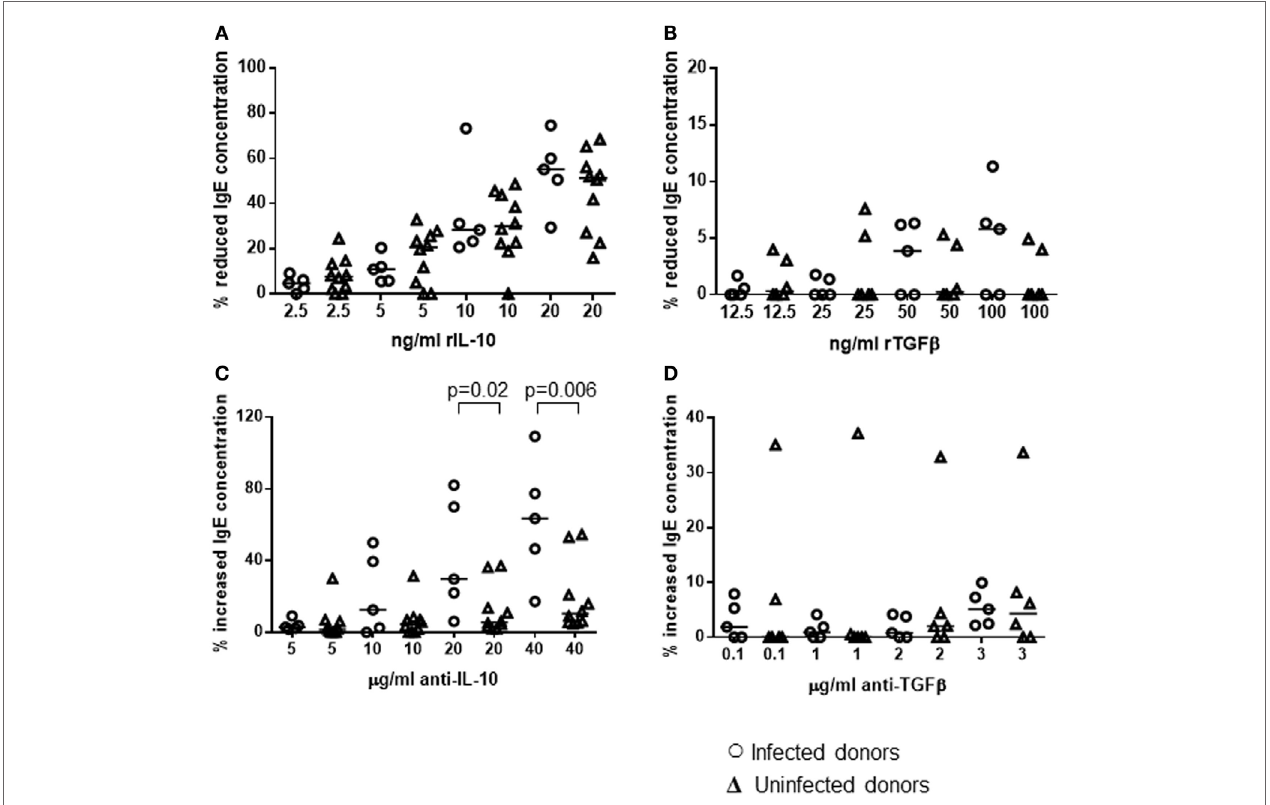
FigUre 7 | influence of recombinant il-10 and TgF β or their blocking antibodies on the in vitro ige response of PBMcs from H. pylori -infected and -uninfected donors . PBMCs from 5 infected and 10 uninfected donors were cultured for 12 days under Th2-skewing conditions, with the addition of rIL-10 (a) , rTGF β (B) , anti-IL-10 (c) , or anti-TGF β (D) blocking monoclonal antibodies. Equivalent volumes of medium were added to further wells as controls for recombinant cytokines; equivalent concentrations of isotype control antibodies were added as controls for the cytokine-blocking antibodies. Total IgE concentrations were assayed by ELISA and the percentage change was calculated for each individual with respect to the control cultures. Points represent the results from individuals and horizontal lines depict the